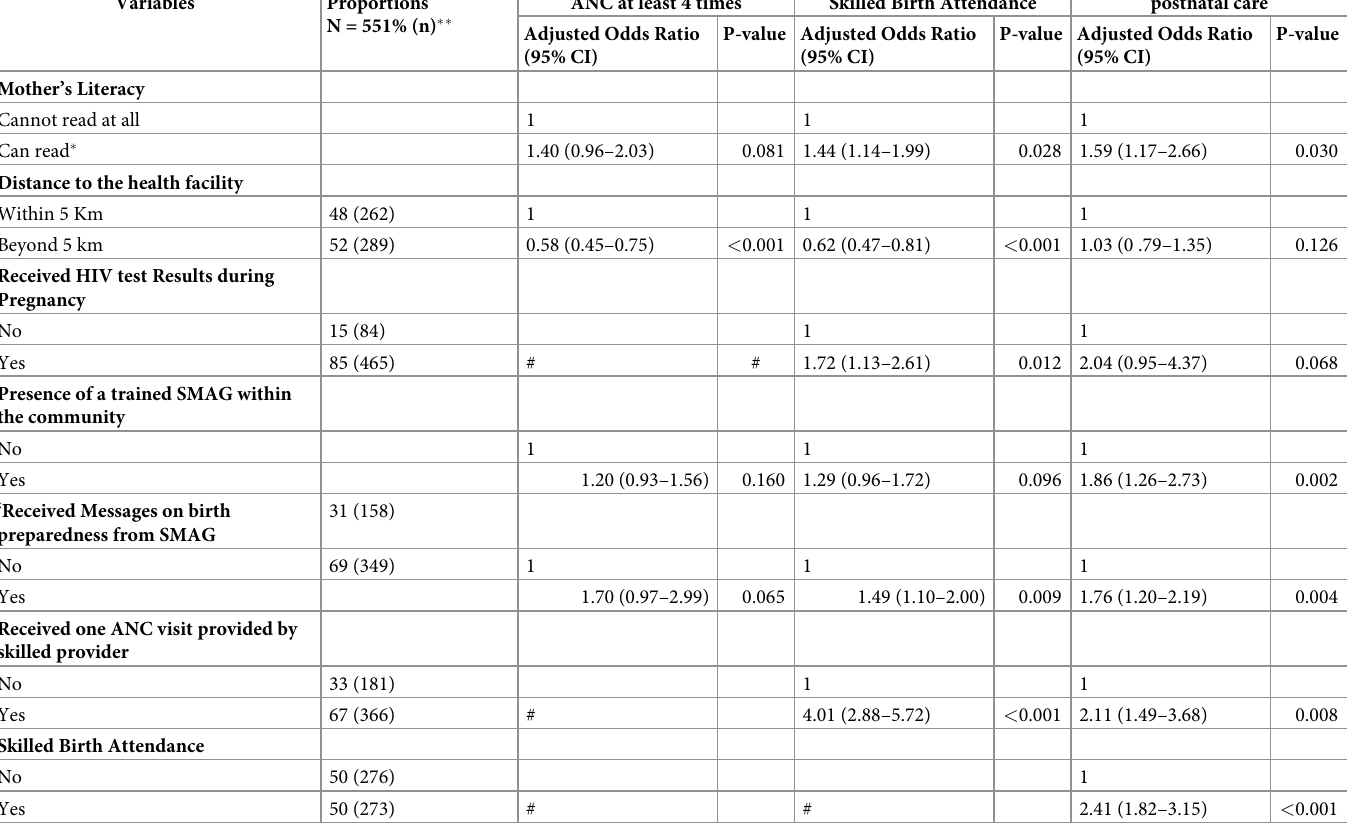
Table 3. Results of the logistic regression analysis of the factors related to the endline outcome of use of the three selected core indicators (ANC at least four times, SBA, PNC with 48 hours by a SMAG) over a three year time period.